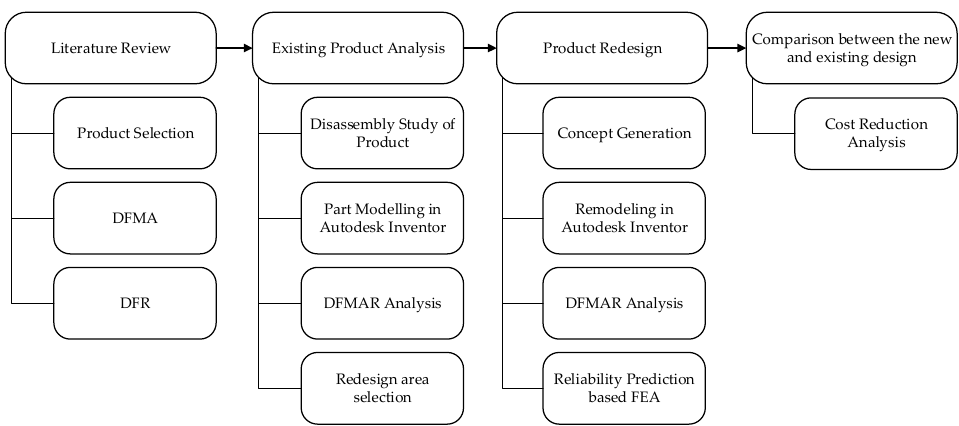
Figure 3. Design for Manufacturing, Assembly, and Reliability (DFMAR): an implementation ap- proach.